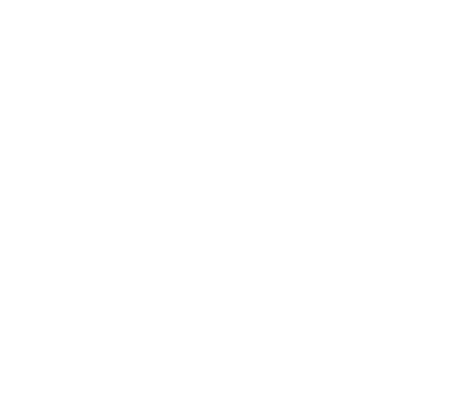
Figure 6. Venn diagram of age-related methylated genes in four mammals (rhesus macaques, humans, mice and dogs).